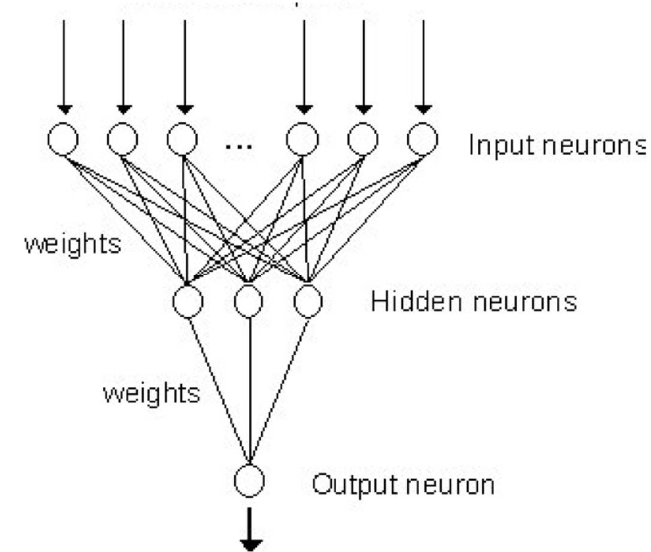
Figure 3. FFNN architecture [30].